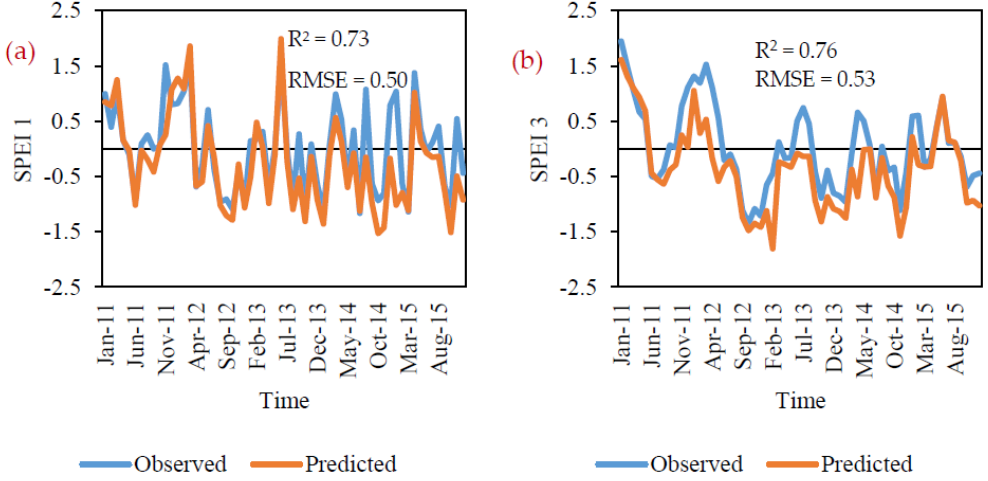
Figure 7. Variation between actual and predicted ( a ) SPEI 1 and ( b ) SPEI 3 values across all the pixels of the study region.